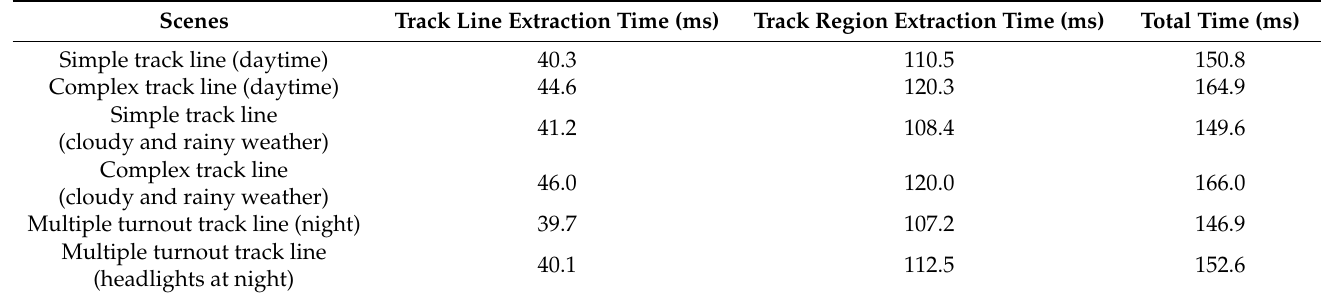
Table 3. Comparison of the extraction time for track areas in different scenes under the condition of finite computational